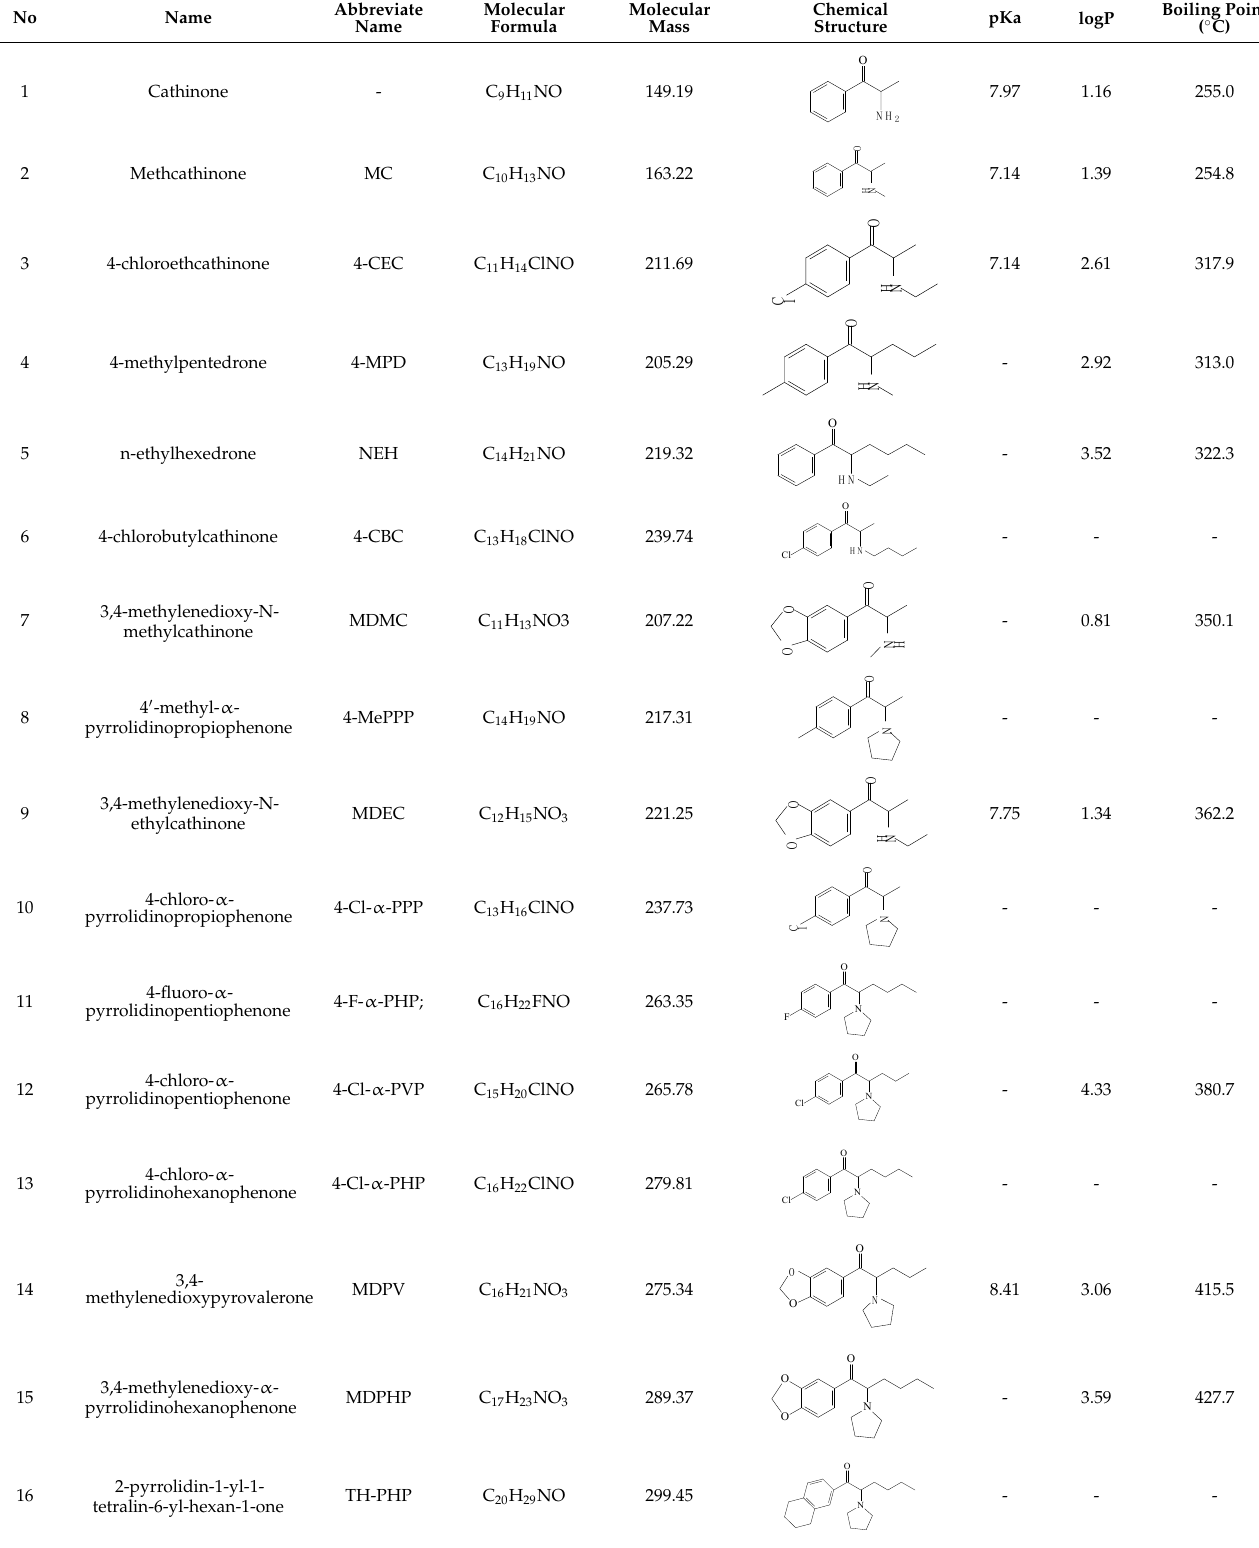
Table 1. Physical and chemical parameters of 16 kinds of synthetic cathinones.